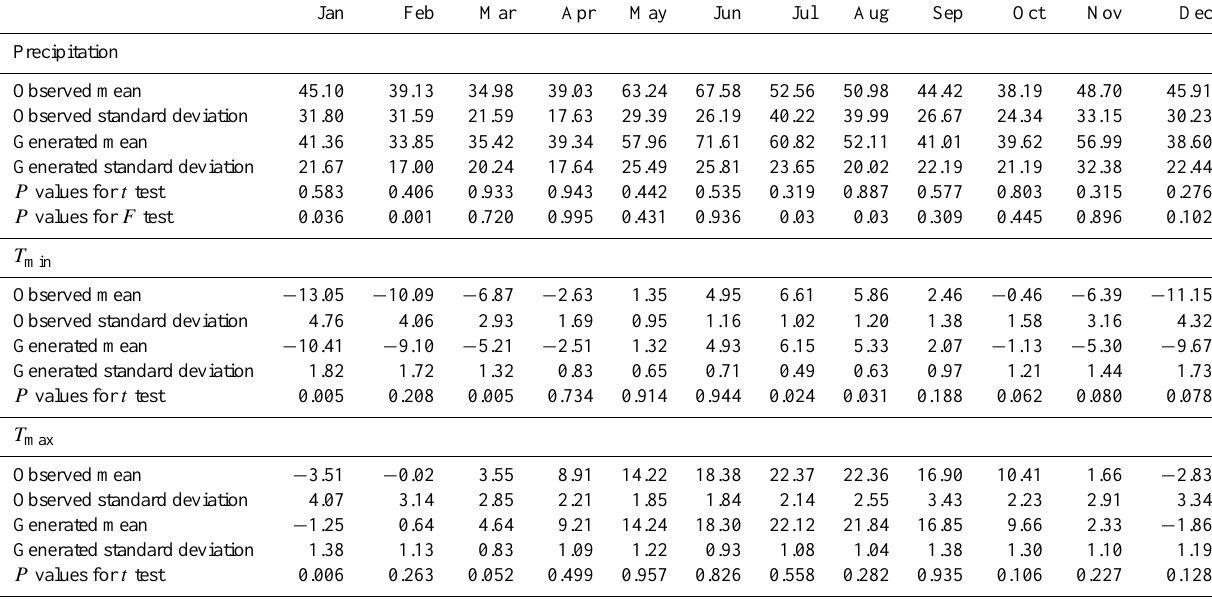
Table 2. Comparison of monthly statistics of daily precipitation, T max and T min observed at Coleman station during the period from 1965 to 1997 with synthetic data generated by LARS-WG. P values calculated by the t test and F test for the monthly means and variances are shown. A probability of 0.05 or lower indicates a departure from the observations that is significant at the 5% level.